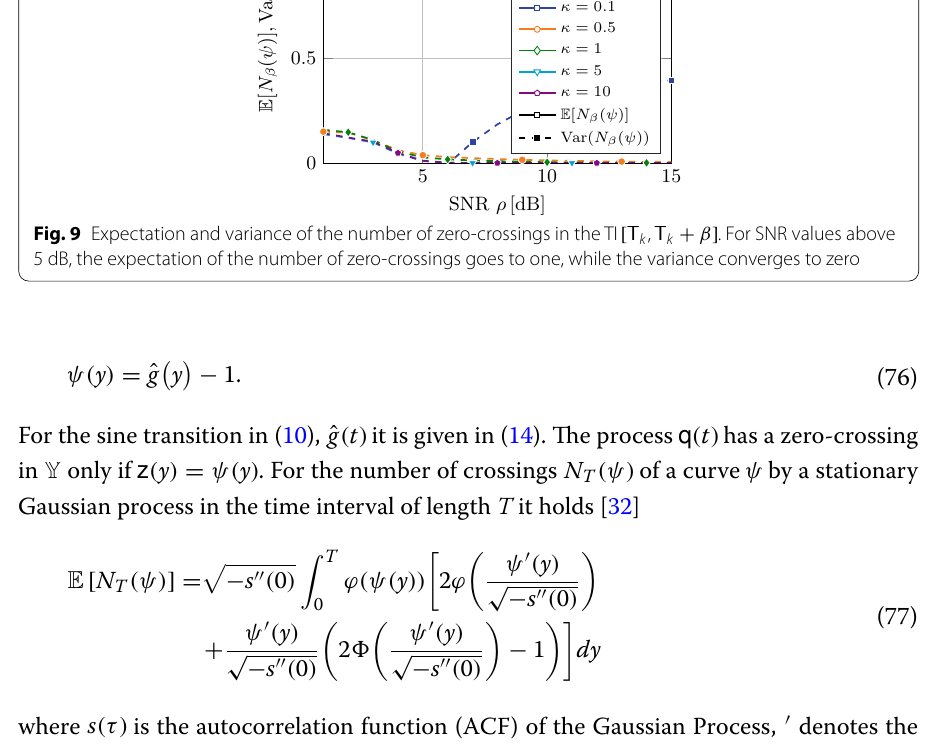
β T k , T k . For SNR values above [ + ]